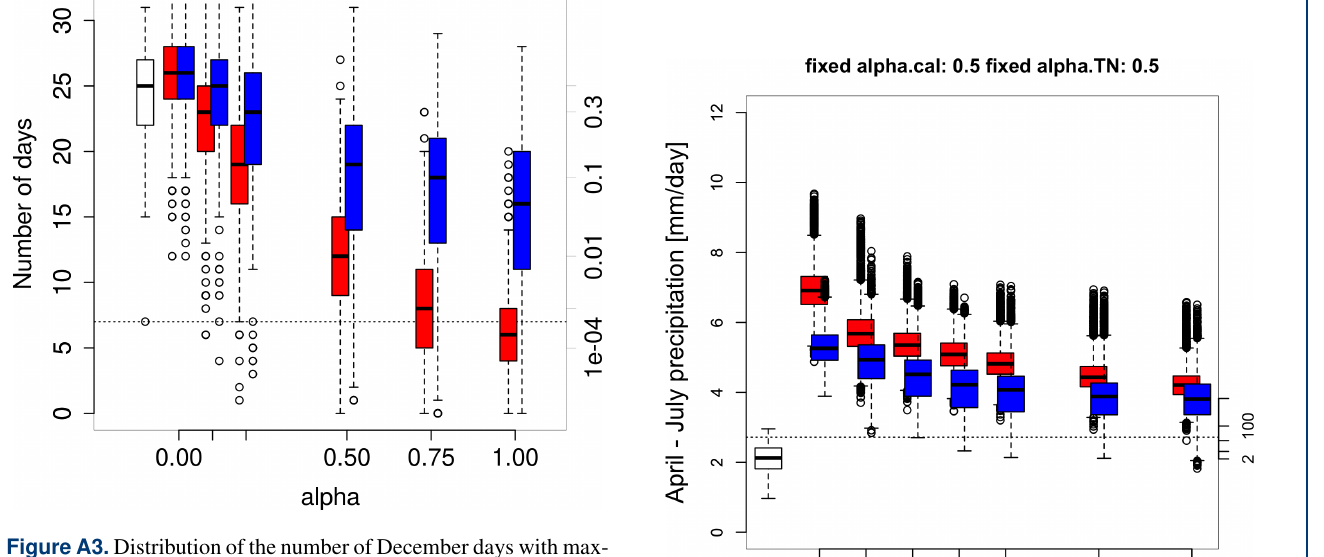
Figure A3. Distribution of the number of December days with max- imal temperatures between 0 and 10 ◦ C in observations (white) and in simulations computed by the static (blue) and dynamic (red) gen- erators as a function of α . The axis on the right indicates the prob- ability of occurrence, assuming a beta-binomial distribution of the number of winter days with parameters estimated from white box- plot. The horizontal dotted line corresponds to the observed num- ber of days in December 2015. The boxes of boxplots indicate the median ( q 50), lower ( q 25), and upper ( q 75) quartiles. The up- per whiskers indicate min[max( T ), 1 . 5 × ( q 75 − q 25)]. The lower whisker has a symmetrical formulation. The points are the simu- lated values that are above or below the defined whiskers.